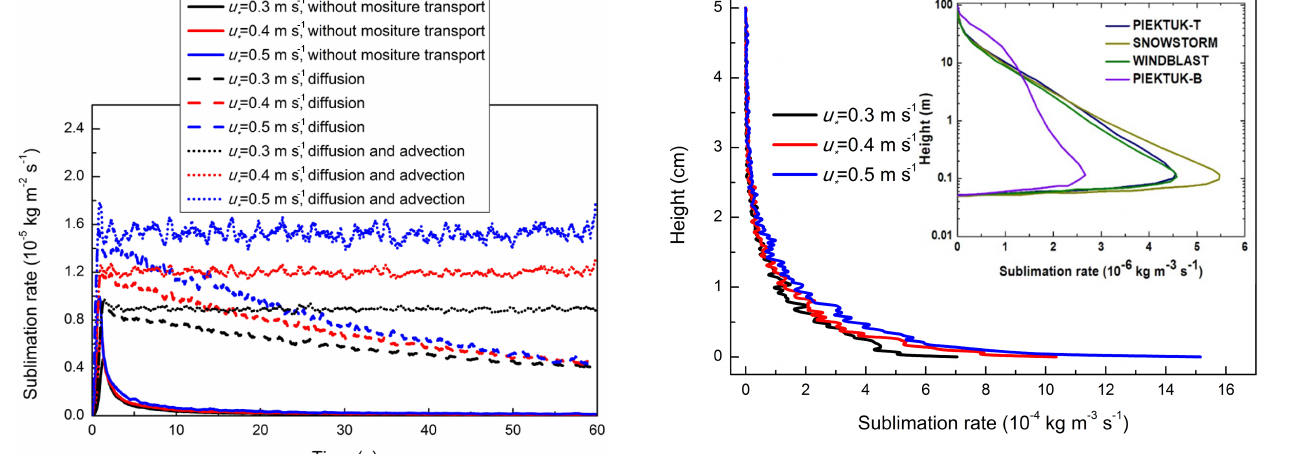
Figure 4. Comparison of the sublimation rate for the saltation layer and suspension layer (the inset figure) at 60s as a function of height. The inset figure shows the sublimation rate of four models for the suspension layer with initial friction velocity of 0.87ms − 1 reported in Xiao et al. (2000). Our results for the sublimation rate in the salta- tion layer are obtained for three wind force levels ( < 0.87ms − 1 ) with moisture diffusion and advection included with the same initial temperature (253.16K) and relative humidity as Xiao et al.